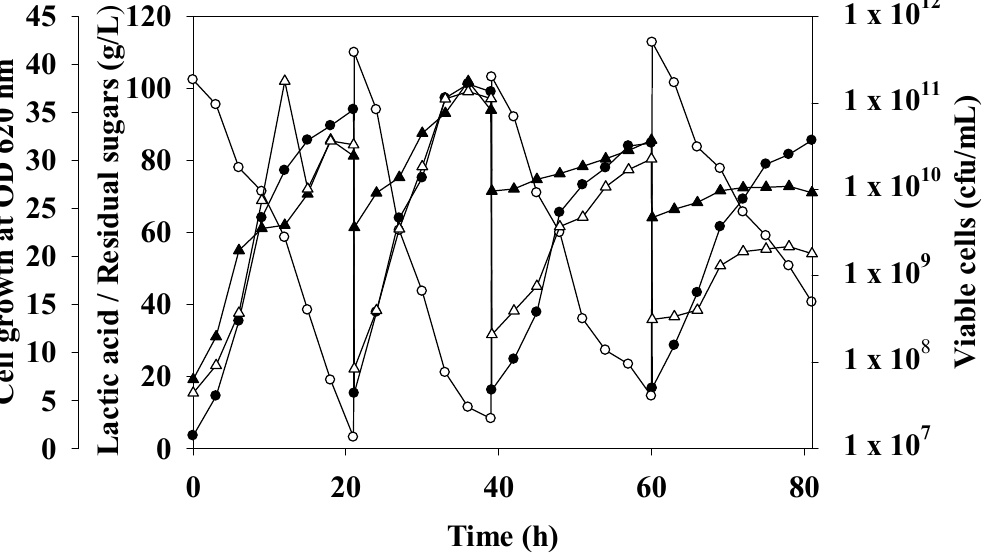
Figure 3. Open repeated batch fermentation of oil palm trunk sap by L. rhamnosus ATCC 10863. Culture was performed in a 2 L fermenter containing 1.2 L working volume at a temperature of 40 ◦ C, agitation speed of 200 rpm, pH 6.5. Lactic acid ( • ), residual sugars ( ), viable cells ( (cid:78) ), and (cid:35) cell growth at OD 620nm ( ∆ ) was